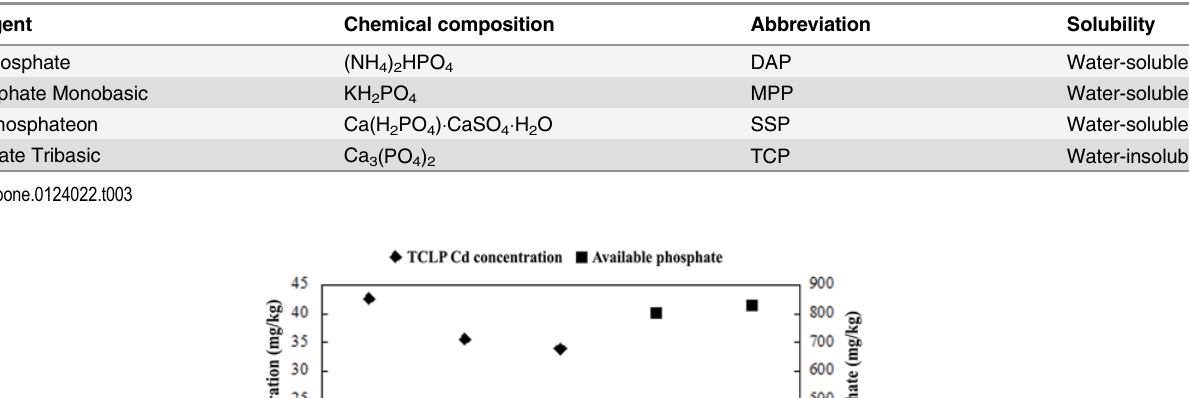
Table 3. Properties of phosphate fertilizers in the study.